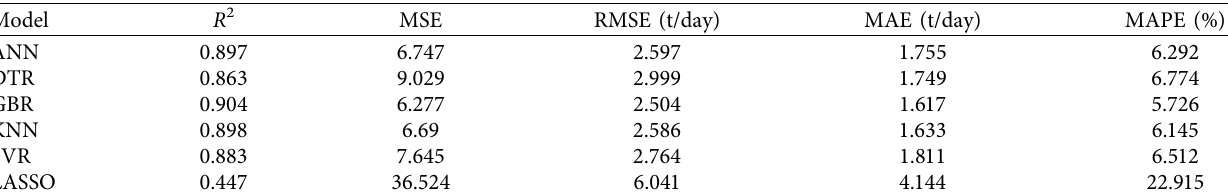
Table 3: Prediction accuracy of